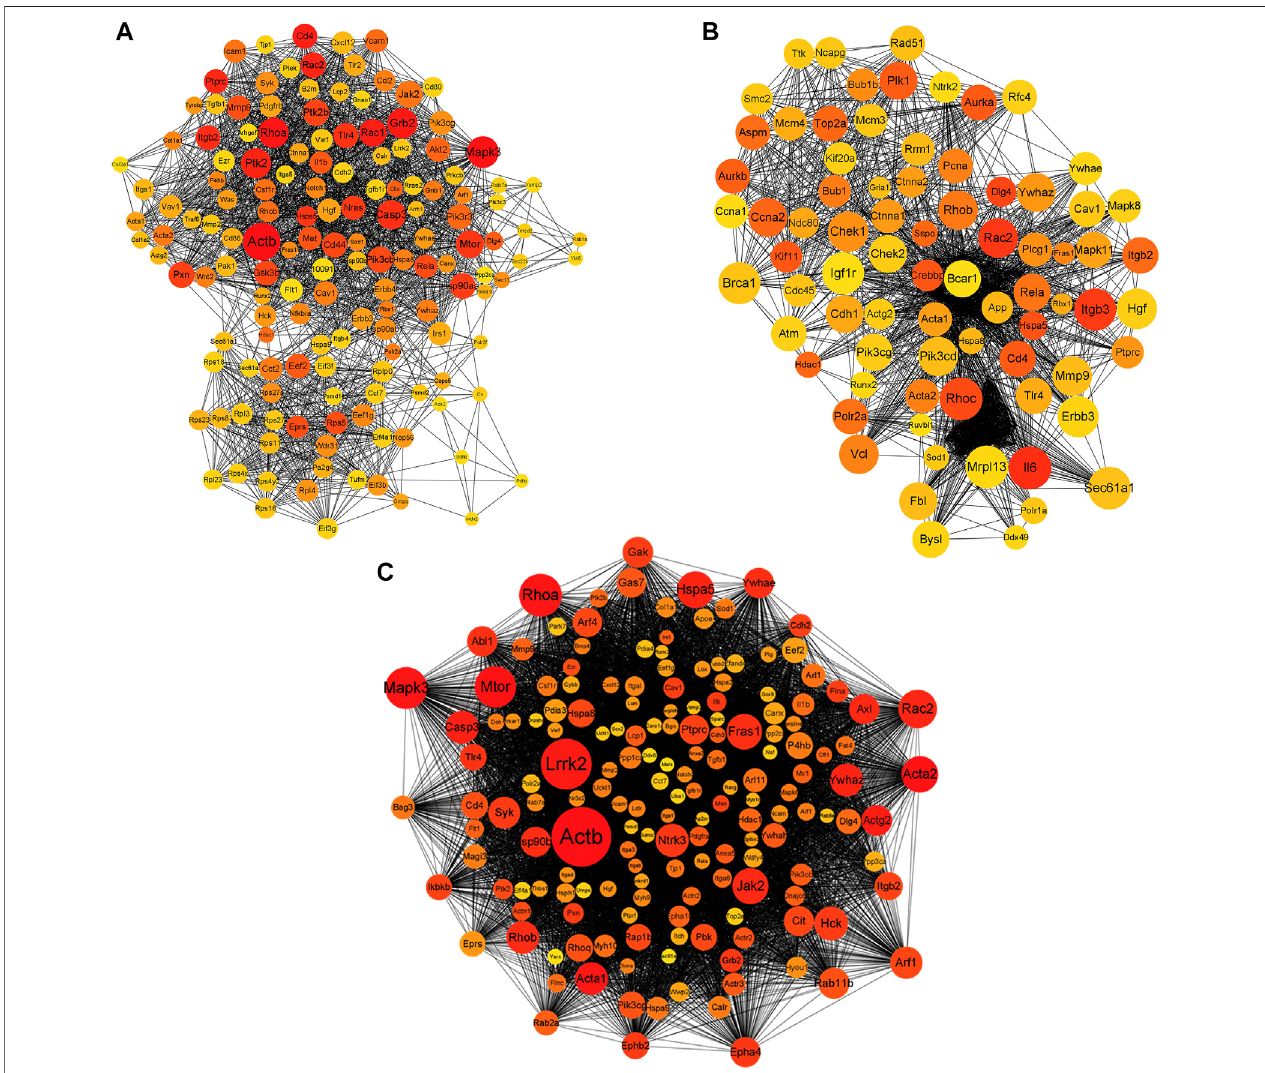
FIGURE7 | PPInetworkofdifferentiallyexpressed genes. (A) PPI networkof differentially expressed genes inastrocytestreated by A β 42oligomers(x12A vs x12). (B) PPI network of differentially expressed genes in astrocytes cultured for 90 days in vitro (x90 vs x12). (C) PPI network of differentially expressed genes in astrocytes treatedbyA β 42oligomersandculturedfor90 days invitro (inbothx12Aandx90comparedwithx12).Thesizeandcolorofnodesrepresenttheirdegreeandnumberof interactions,